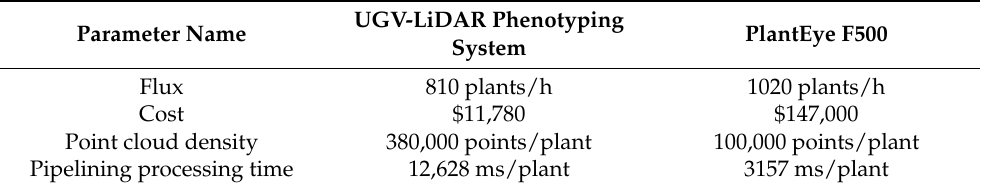
Figure 8. PlantEye F500 measurement principle and physical installation diagram. ( a ) The 3D laser scan sensor. The red and blue lines represent the laser line and reflection of the laser after projecting to the plant to be received by the cmos, respectively. ( b ) The sensor mounted on the overhead orbital system for easy movement. Table 1. Performance and cost comparison between UGV-LiDAR phenotyping system and PlantEye F500.